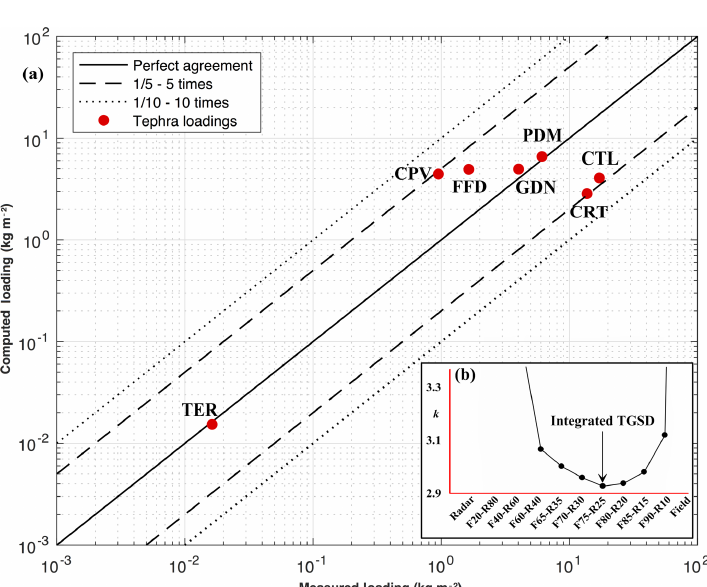
Figure 8. (a) Comparative study between the measured and computed tephra loadings for inverting the Integrated TGSD. (b) Graphic of the k index showing the optimization for assessing the best weighting average combination to apply to the Field and Radar TGSDs (details in Table